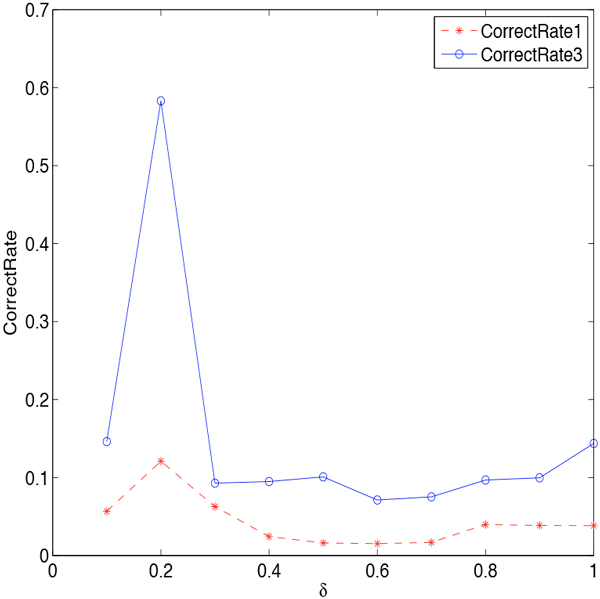
Parameter Sensitivity of δ in Absolute Discounting BPLT+. The influence of parameter δ is investigated: (1) the stars represent the performance of Absolute Discounting BPLT+ under the evaluation metric CorrectRate1; (2) the circles represent the performance of Absolute Discounting BPLT+ under the evaluation metric CorrectRate3; (3) Absolute Discounting BPLT+ achieves its best performance when δ = 0.2.